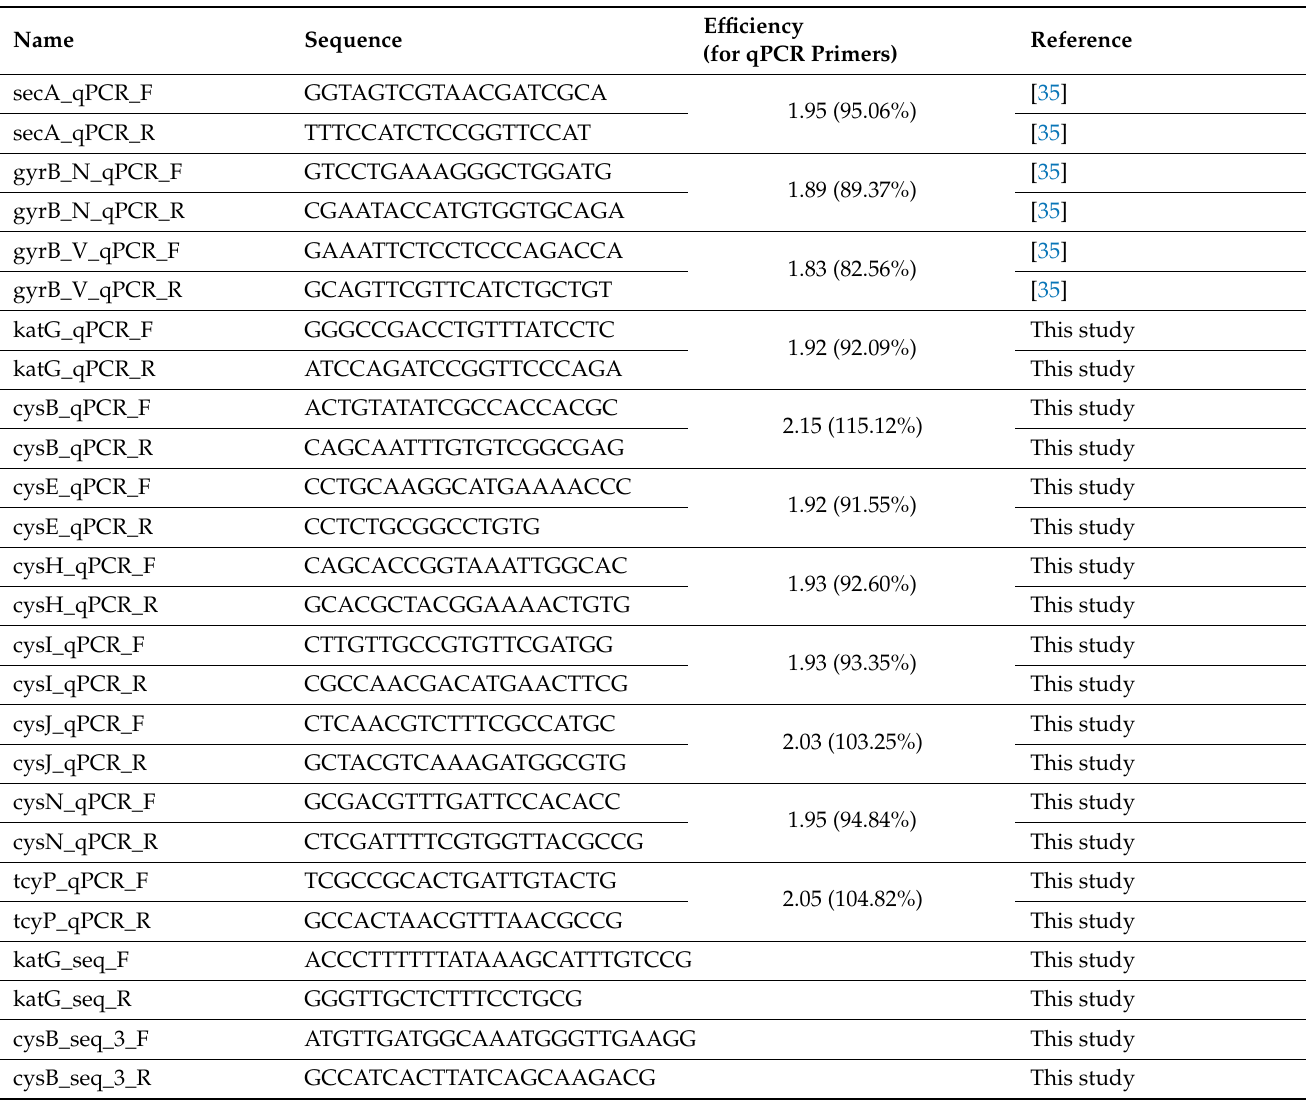
Table 2. Primers used in this